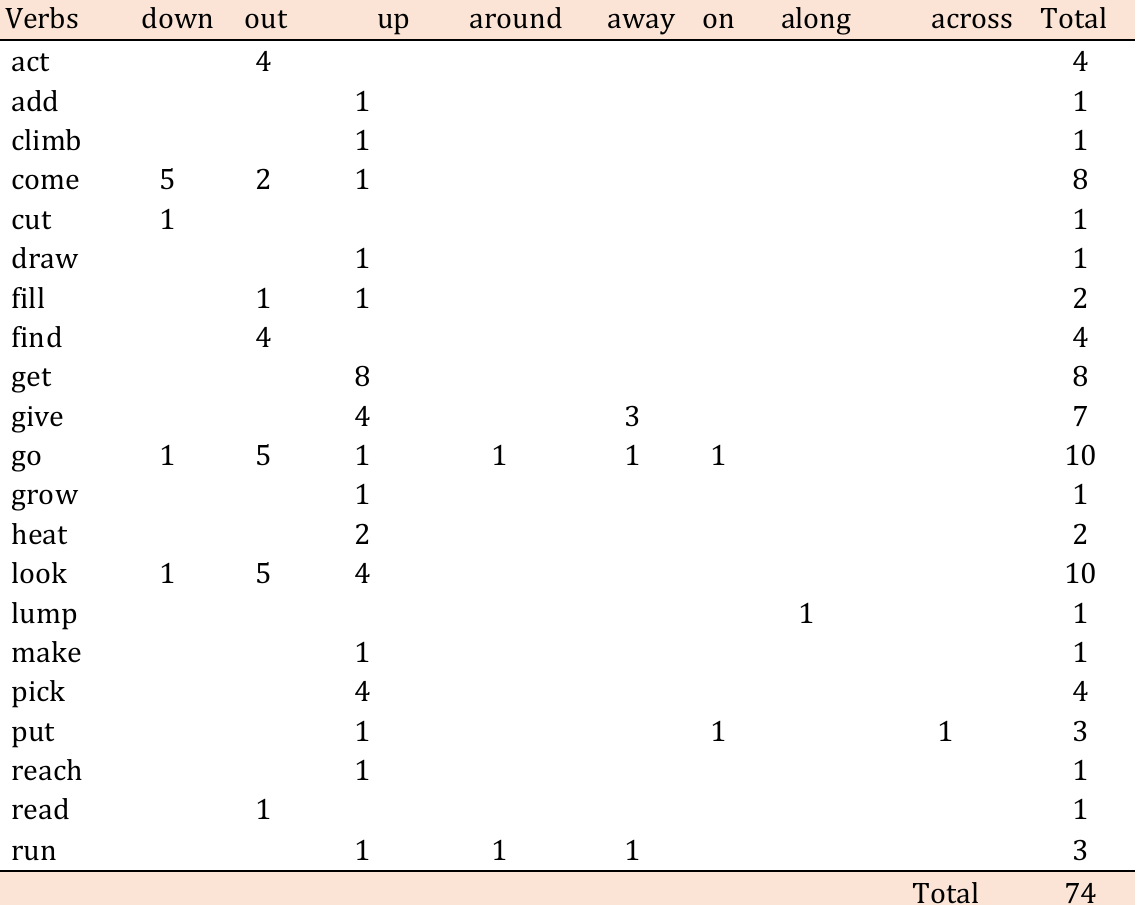
Table 1. The frequency distribution of the Phrasal Verbs and related particles in the textbook